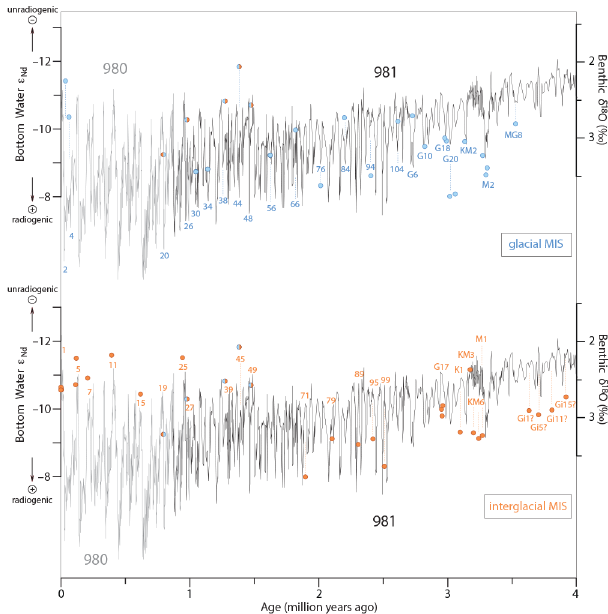
Figure 5. Comparison between changes in bottom-water ε Nd sig- natures and benthic foraminiferal δ 18 O values at site 980/981 for glacial (blue dots) and interglacial (red dots) marine isotope stages (MIS) during the last 4 million years (benthic δ 18 O data from Raymo et al., 2004; Lisiecki and Raymo, 2005 and references therein). Samples reflecting the transition from glacial to inter- glacial condition are shown in dots colored in blue and red.